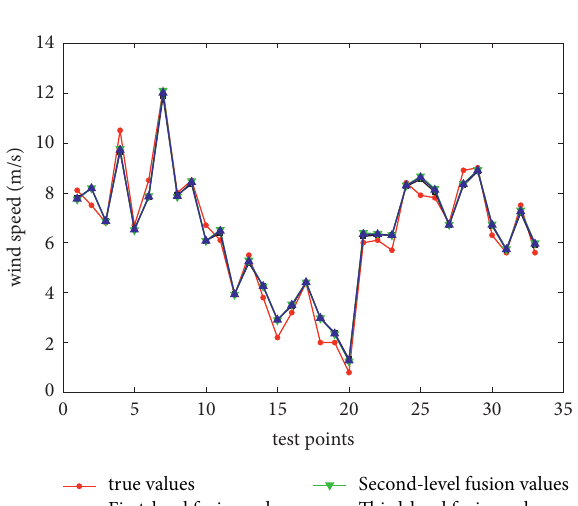
Figure 7: Third-level fusion values.